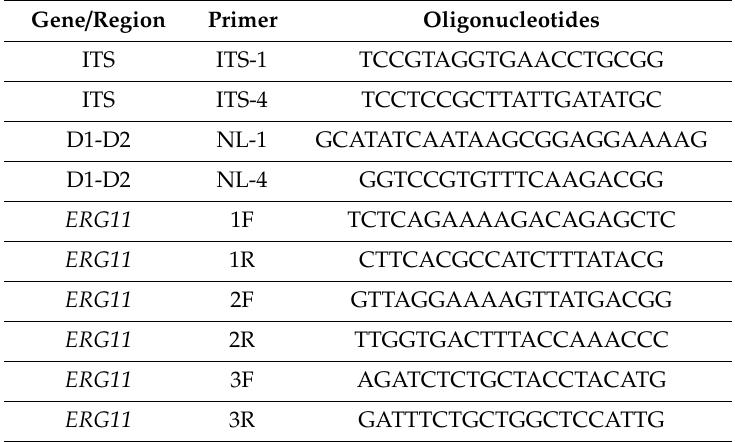
Table 2. Primers used for